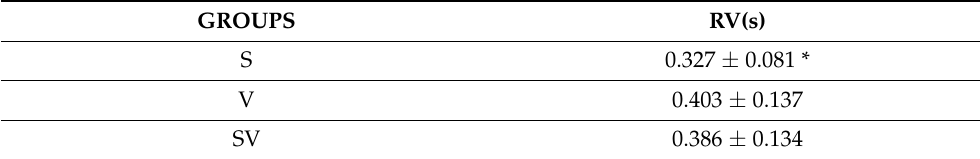
Table 3. Reaction time values in different